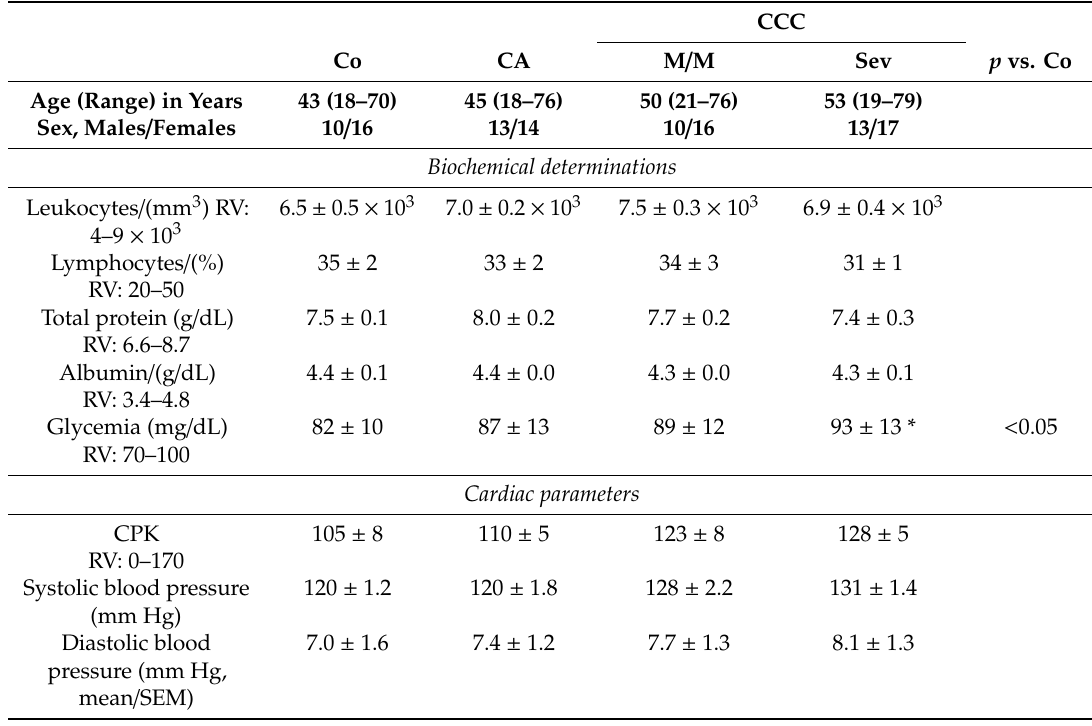
Table 1. Characteristics of the groups of patients included in the study. CCC Co CA M / M Sev p vs.